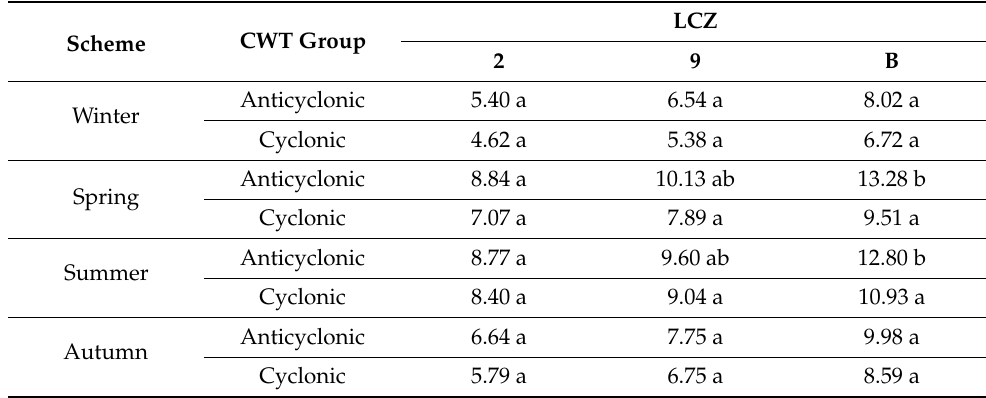
Table 6. Significance of DTR variation among LCZ groups for each Season and each CTW. Average values [ ◦ C] are shown. Letters a, b represent significant differences among groups.